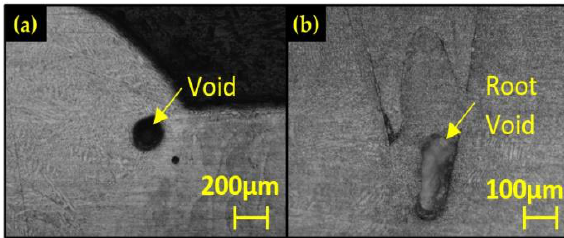
Figure 8: (a) Porosity in the nail head region at the top of the weld of sample 12A (272.6J/mm), (b) root void in the weld of sample 13A (249.8J/mm)